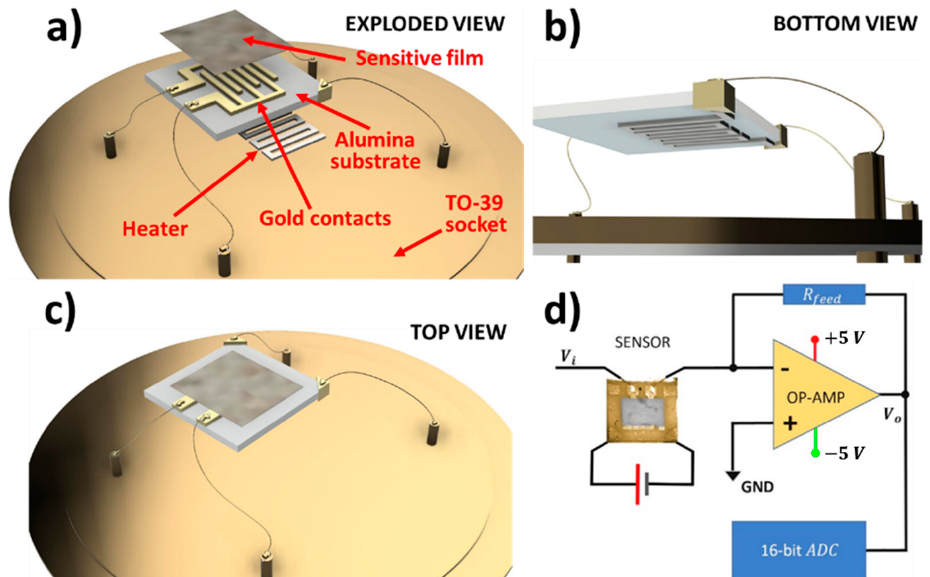
Figure 3. The sensor, its parts and its connection to the electronic circuit. ( a ) Exploded views of the sensor assembly; ( b ) bottom view; ( c ) top view; ( d ) outline of one sensor circuitry: microphotograph of a sensor (2.5 × 2.5 mm) connected in between the voltage source V i and the operational amplifier in an inverting configuration; the sensor heater contacts are connected to an adjustable voltage source; the output signal V o is digitized by a 16 bit analog-to-digital converter and sent to an external host computer via a USB serial port.